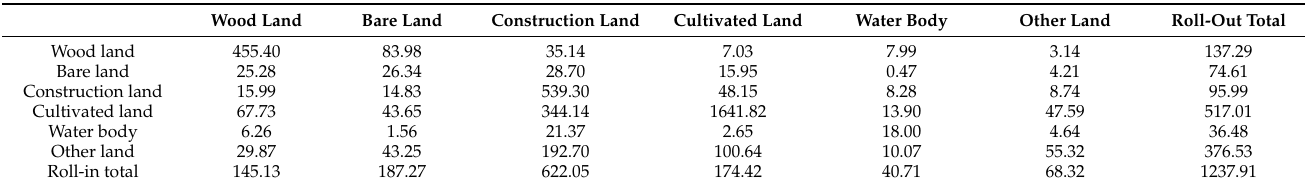
Table 6. Land use transfer matrix of Jiaozuo City from 2003 to 2011 (km 2 ).